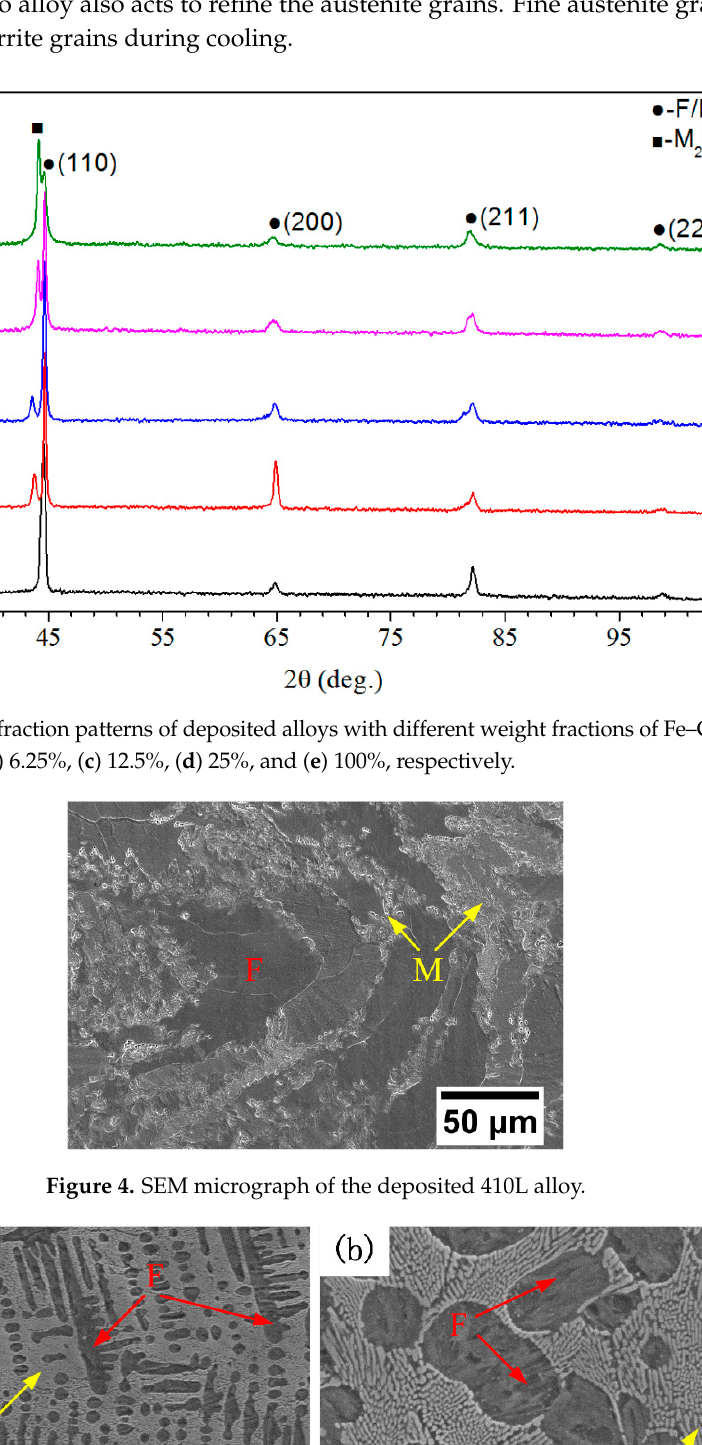
Figure 4. SEM micrograph of the deposited 410L alloy.